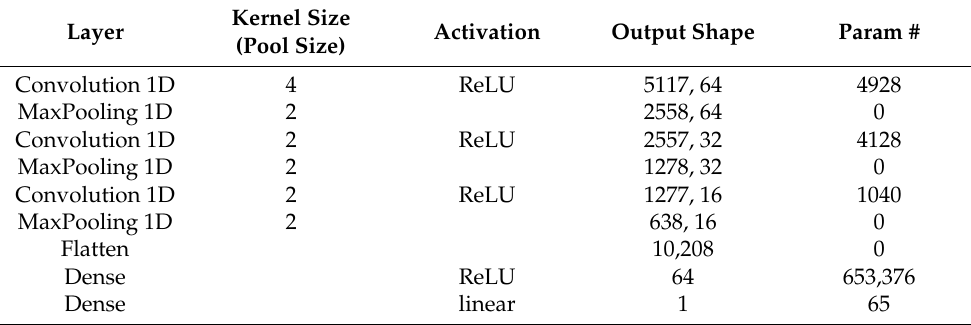
Table 1. Parameters of the signal-based baseline model.